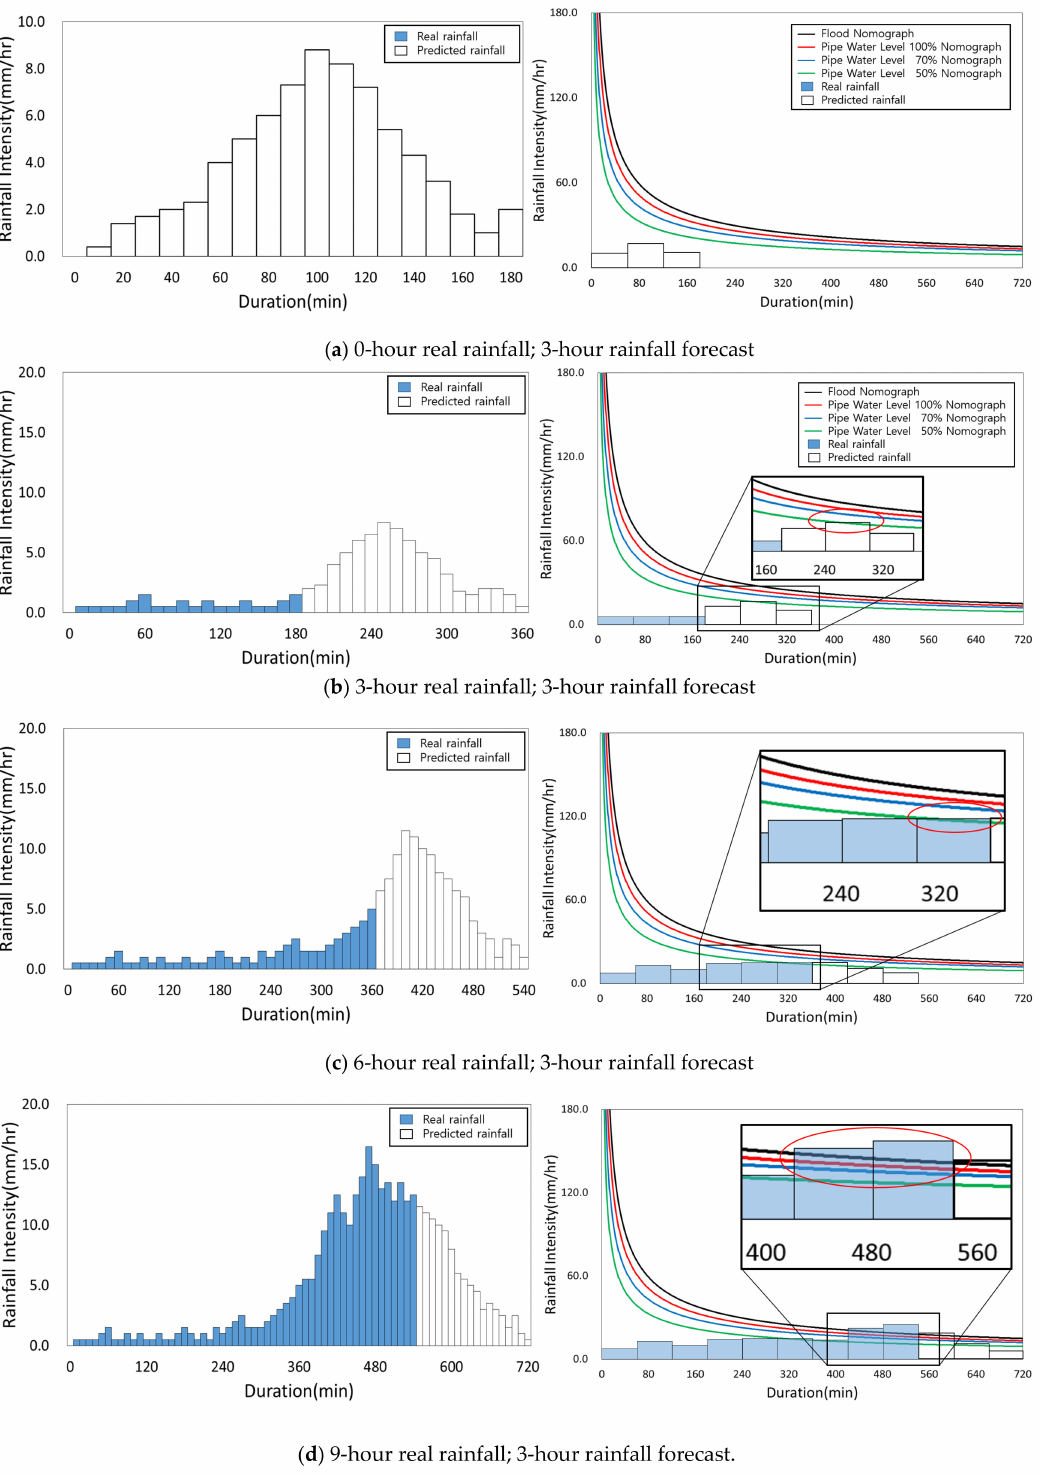
Figure 10. Application of the improved flood nomograph with historical rainfall data (Geoje